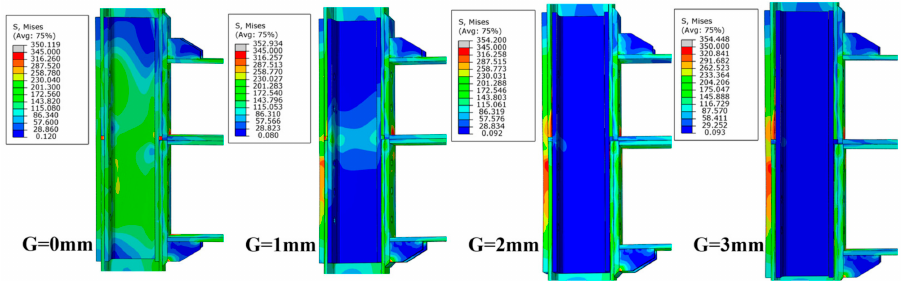
Figure 24. Stress distribution of connections with different construction errors.